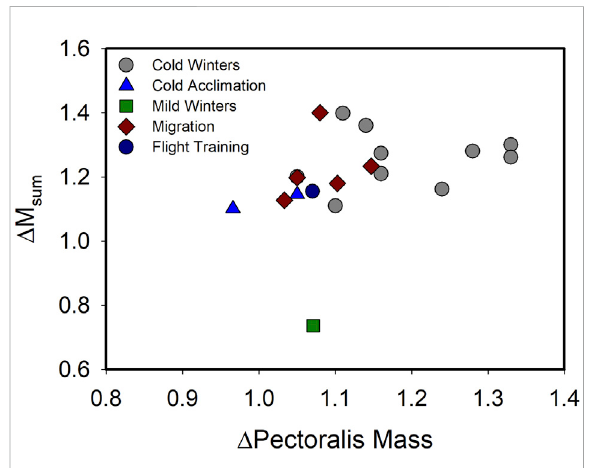
FIGURE 1 Relationship of variation in pectoralis muscle mass ( Δ Pectoralis Mass) with variation in summit metabolic rate ( Δ M sum ) across a range of natural acclimatization (winter vs. summer in climate with cold or mild winters, migratory vs. non- migratory conditions) and experimental acclimation (cold vs. warm, fl ight training vs. control) for birds. A linear regression on these data indicated no signi fi cant relationship ( F 1,17 = 1.918, p = 0.184), including after removal of the “ Mild Winters ” data point ( F 1,16 = 2.775, p = 0.115), suggesting that despite increases in both M sum and pectoralis muscle mass often occurring under conditions of increasing energy demand in birds, the two traits are not tightly coupled. Data from Swanson (1990), Swanson (1991), Swanson (1995), O ’ Connor (1995a), O ’ Connor (1995b), Cooper (2002), Cooper and Swanson (1994), Petit et al. (2014), Liknes and Swanson (2011), Sgueo et al. (2012), Swanson et al.